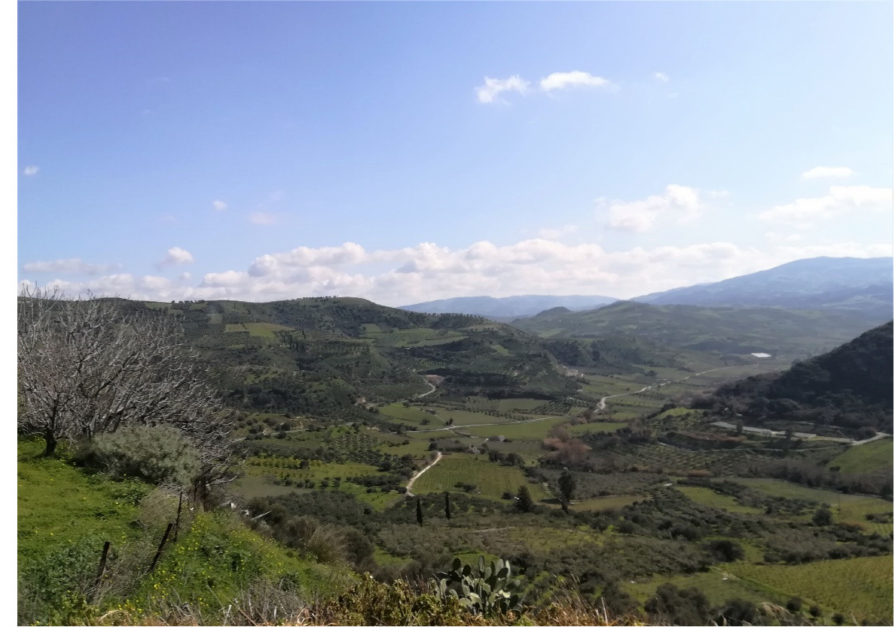
Figure 2. The horticulture-driven landscape in the area of